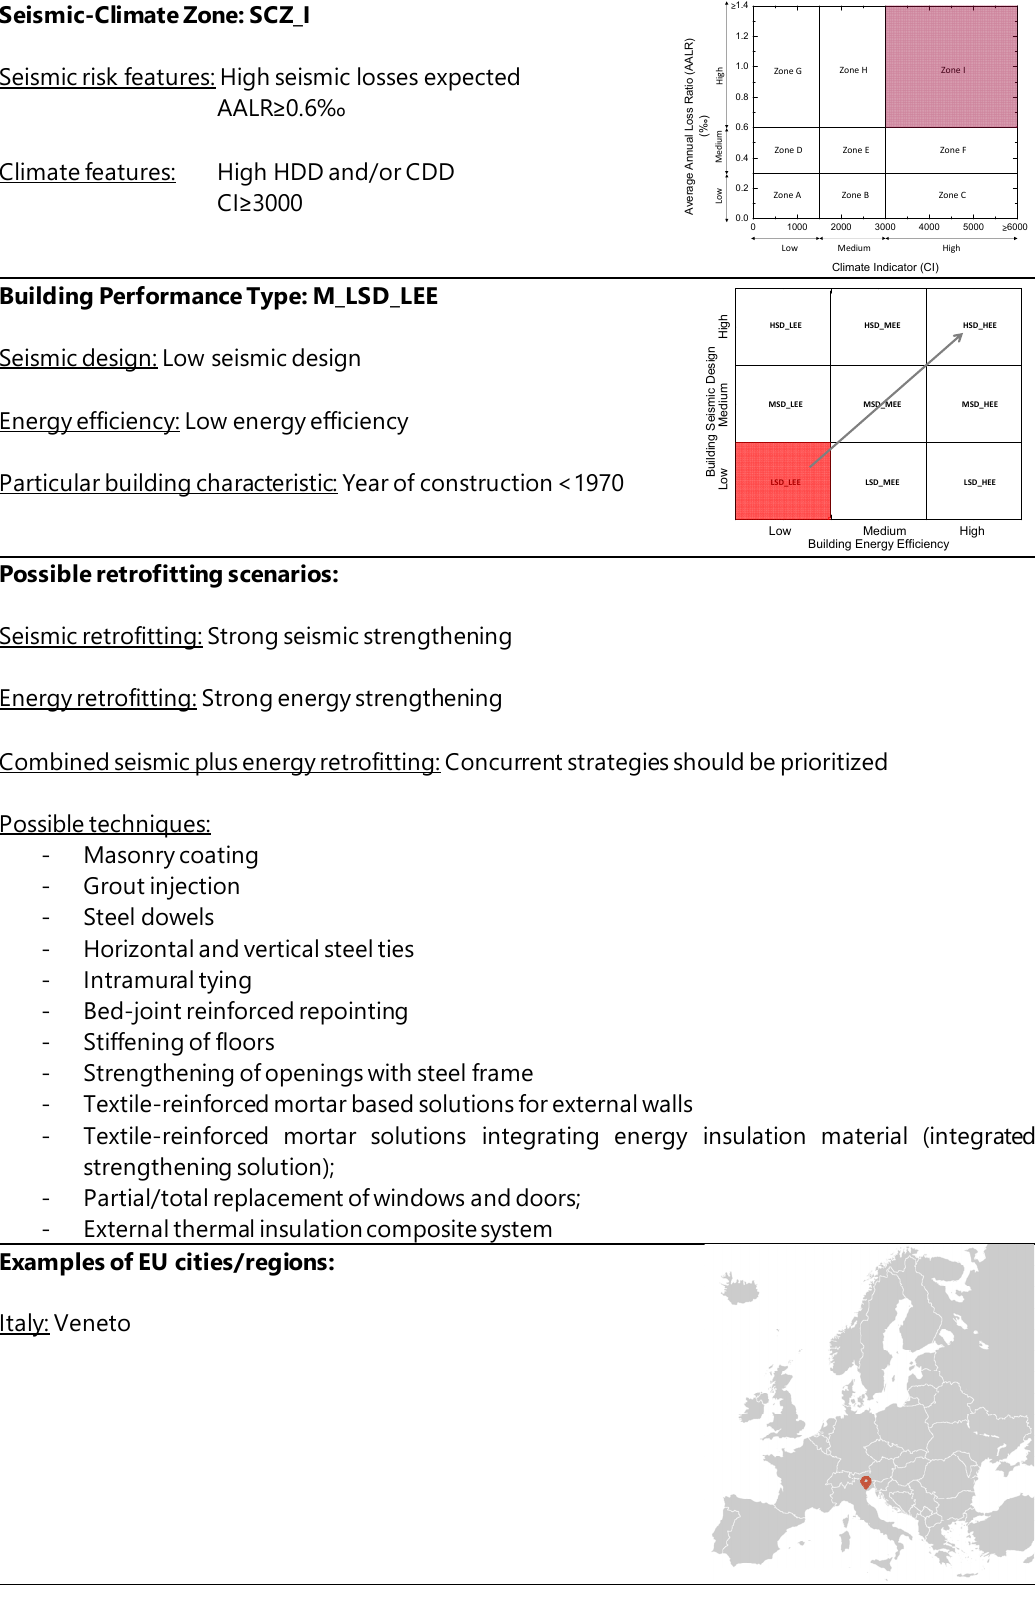
Figure 13. Retrofitting scenario 3: SCZ_I and M_LSD_LEE.